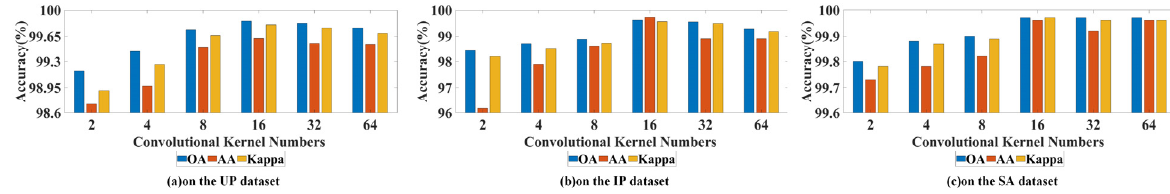
Figure 9. The effect of convolutional kernel numbers in ALU.